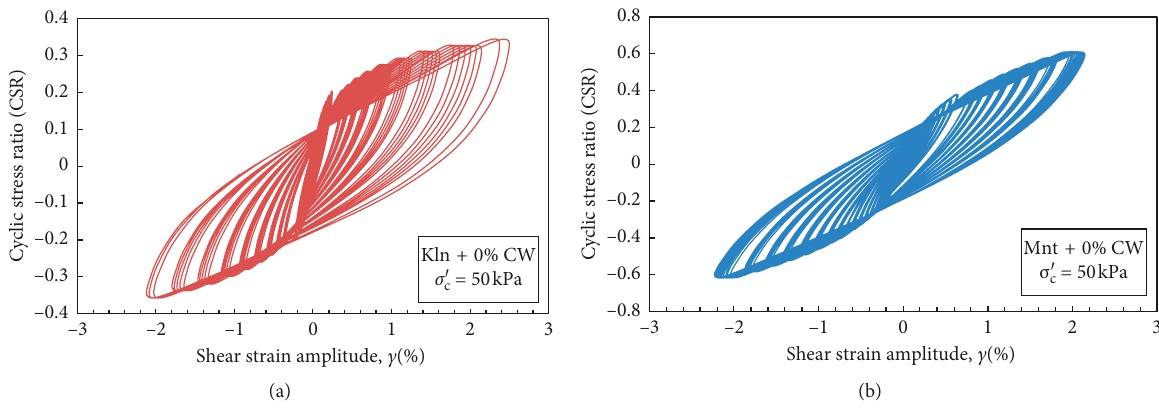
Figure 4: Hysteresis loops of control samples: (a) Kln+0% CW; (b) Mnt+0% CW.